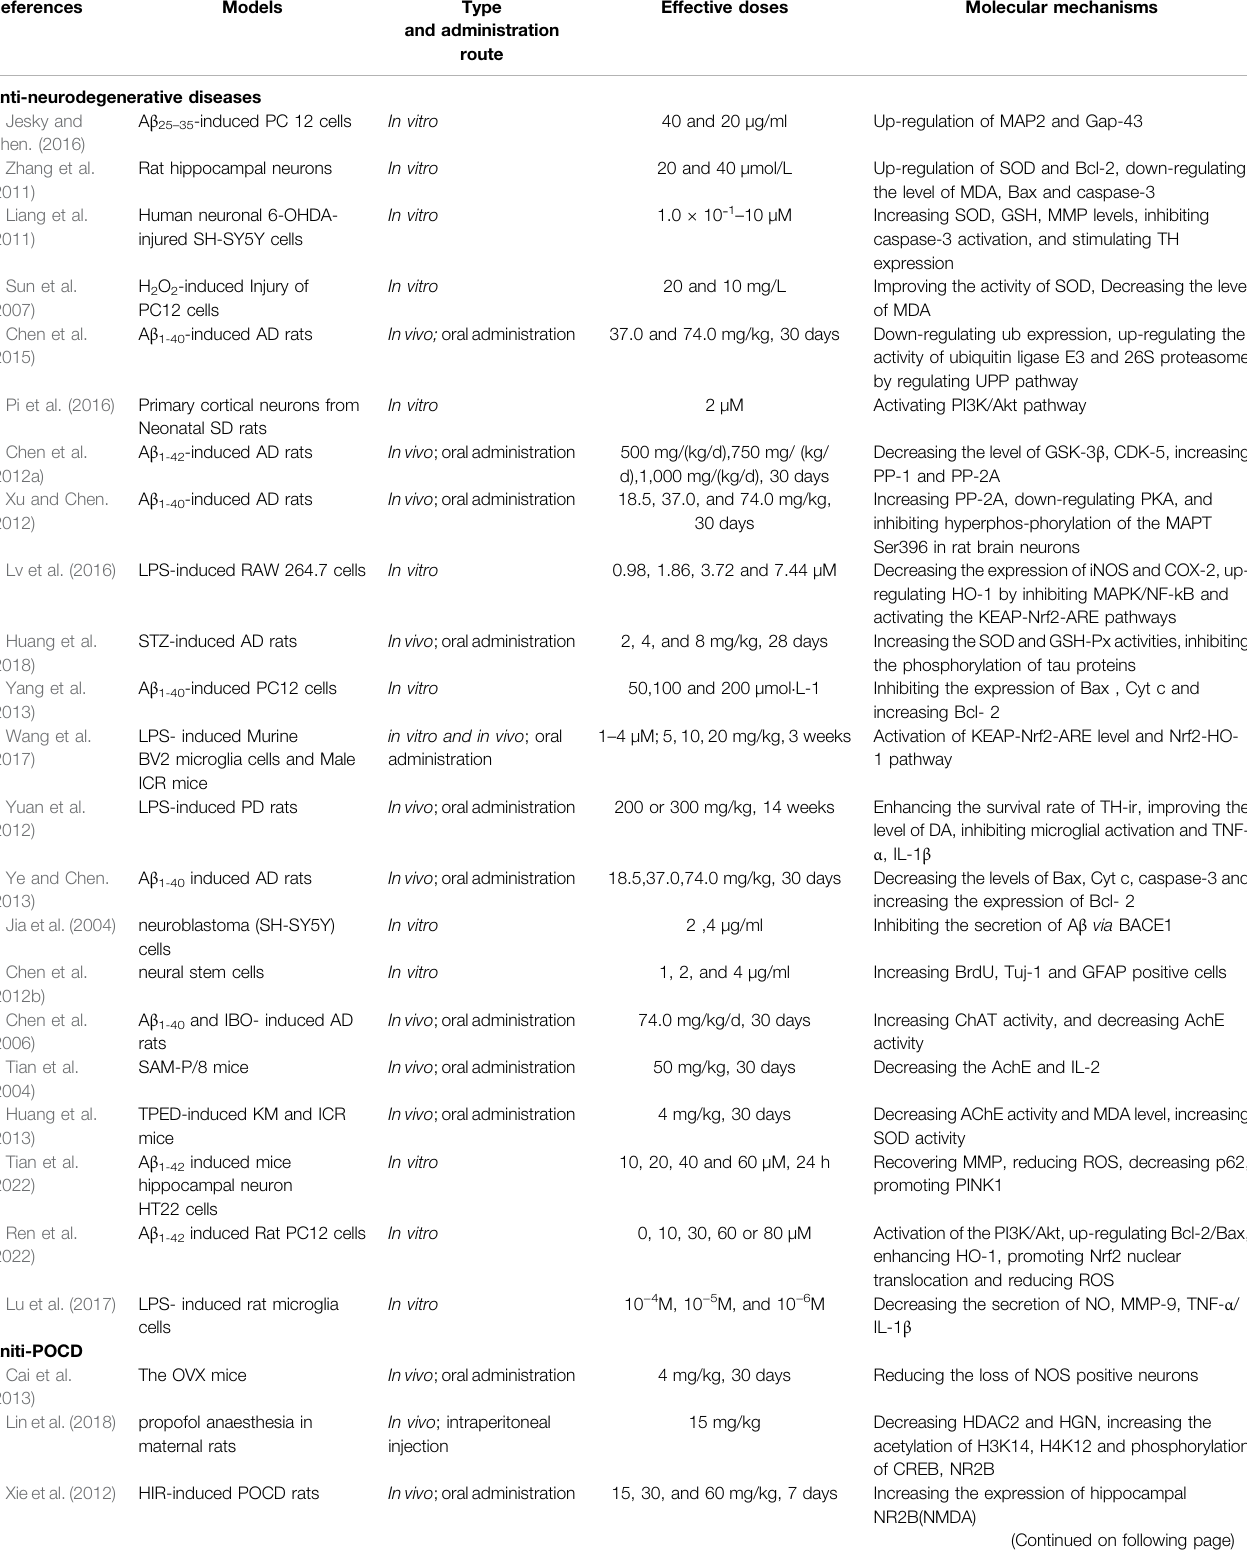
TABLE 1 | Molecular mechanisms to the pharmacological activity of